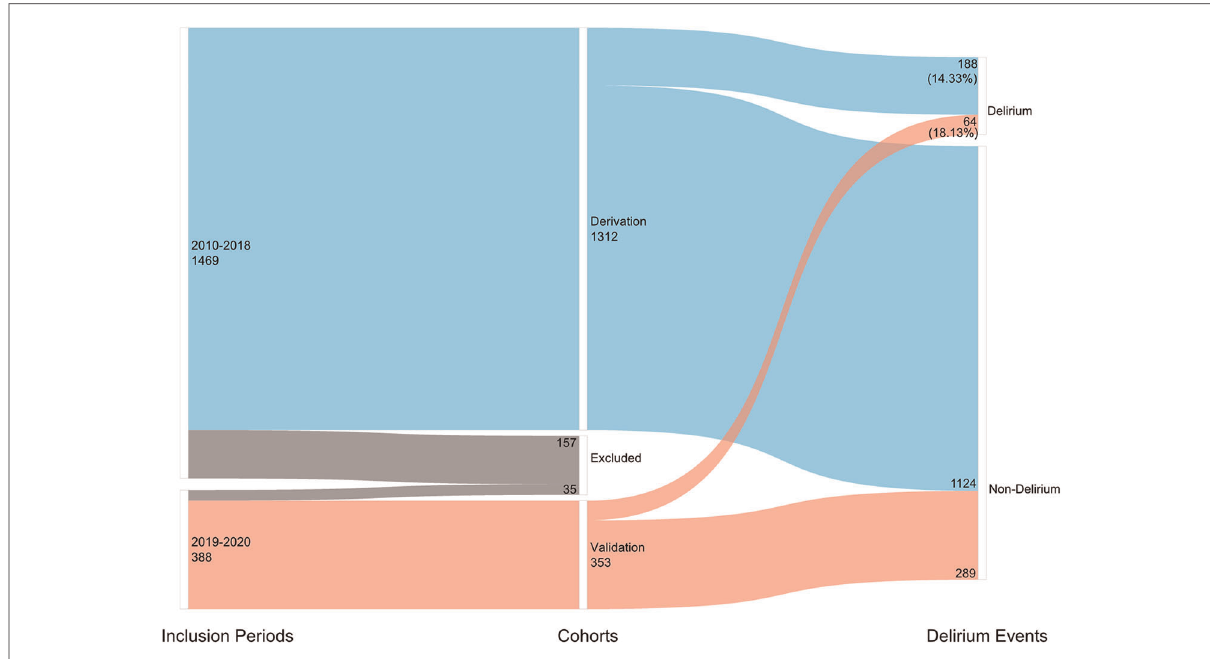
FIGURE 1 Number of included patients in different inclusion periods and the number of postoperative delirium